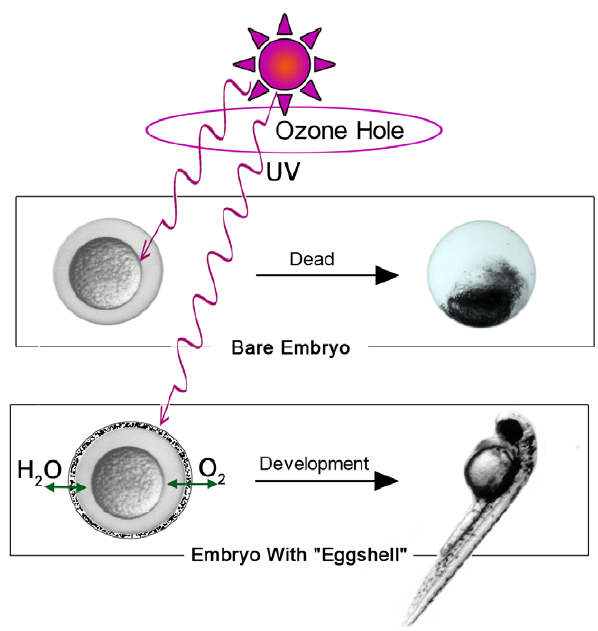
Figure 5. Schematic illustration of the protection by shell engineering. The coated embryo with mineral shell can develop and hatch successfully within the man-made shield under ozone hole but the bare one cannot accomplish the embryonic